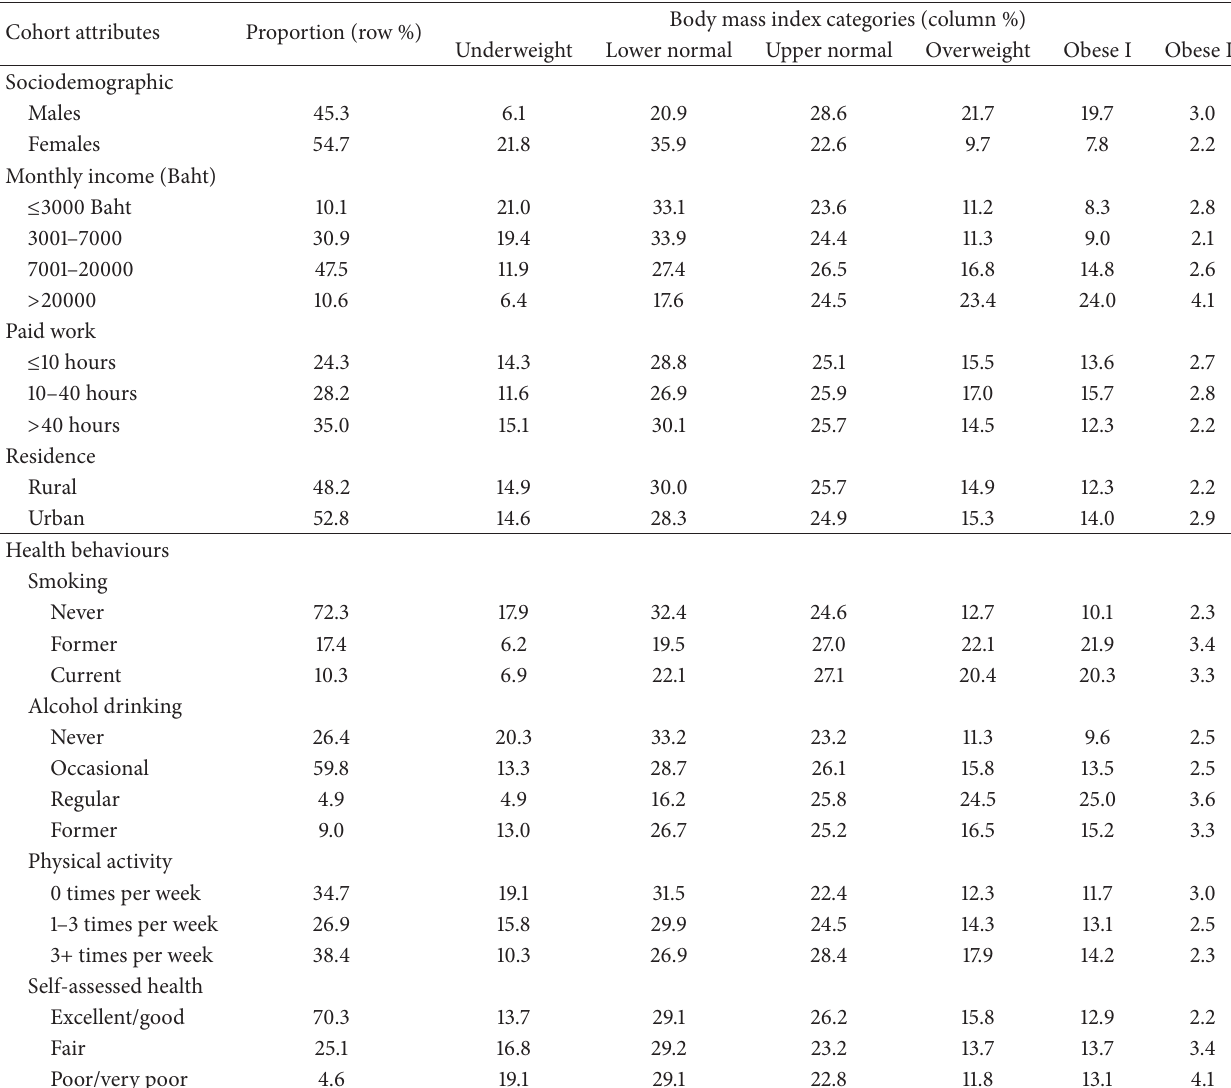
Table 2: Cohort attributes by body mass index categories, Thai Cohort Study